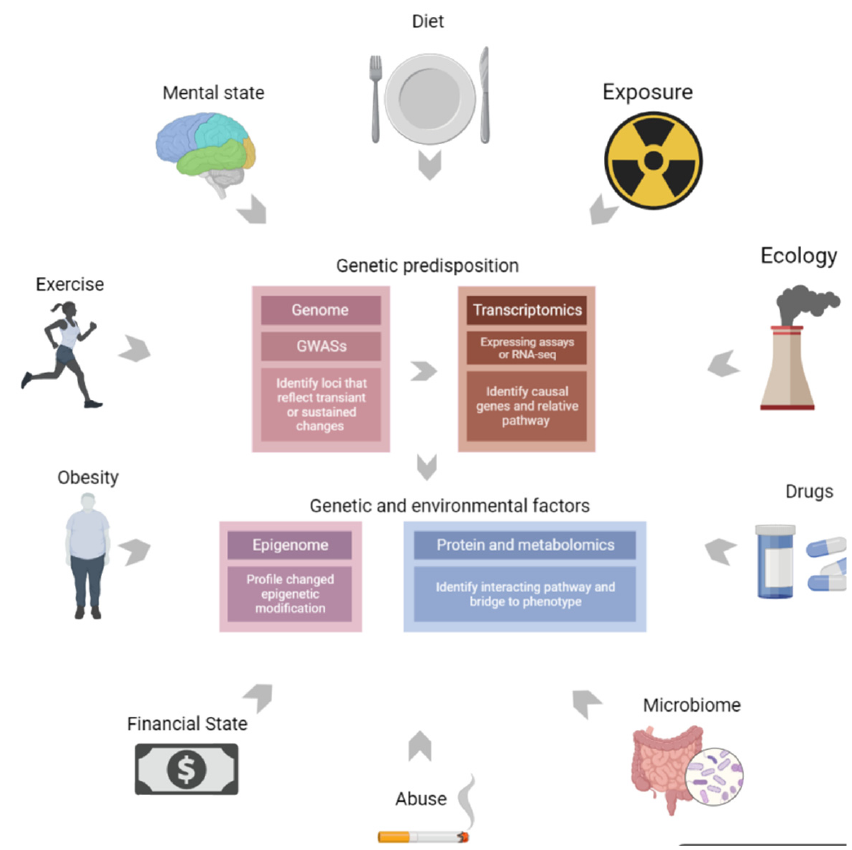
Figure 1. Multi-omics combine genetic predisposition with environment factors. Multi-omics can combine genetic predisposition, RNA regulation, and environmental exposure factors to describe diseases comprehensively and intensively.